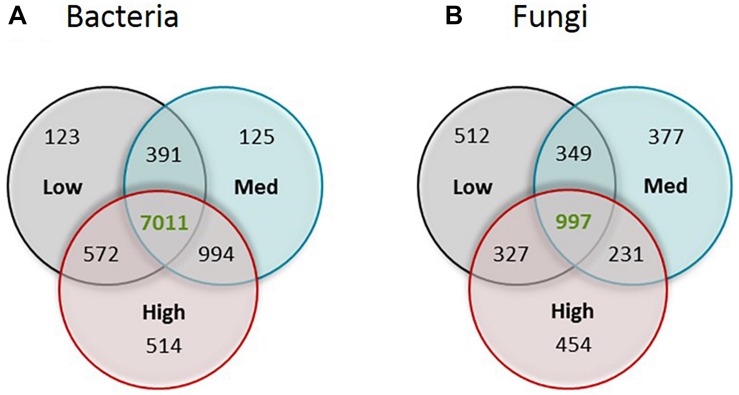
Venn diagram showing the number of unique OTUs of (A) bacteria and (B) fungi for each of the rotundone zone and shared between the three rotundone-based soil zones.